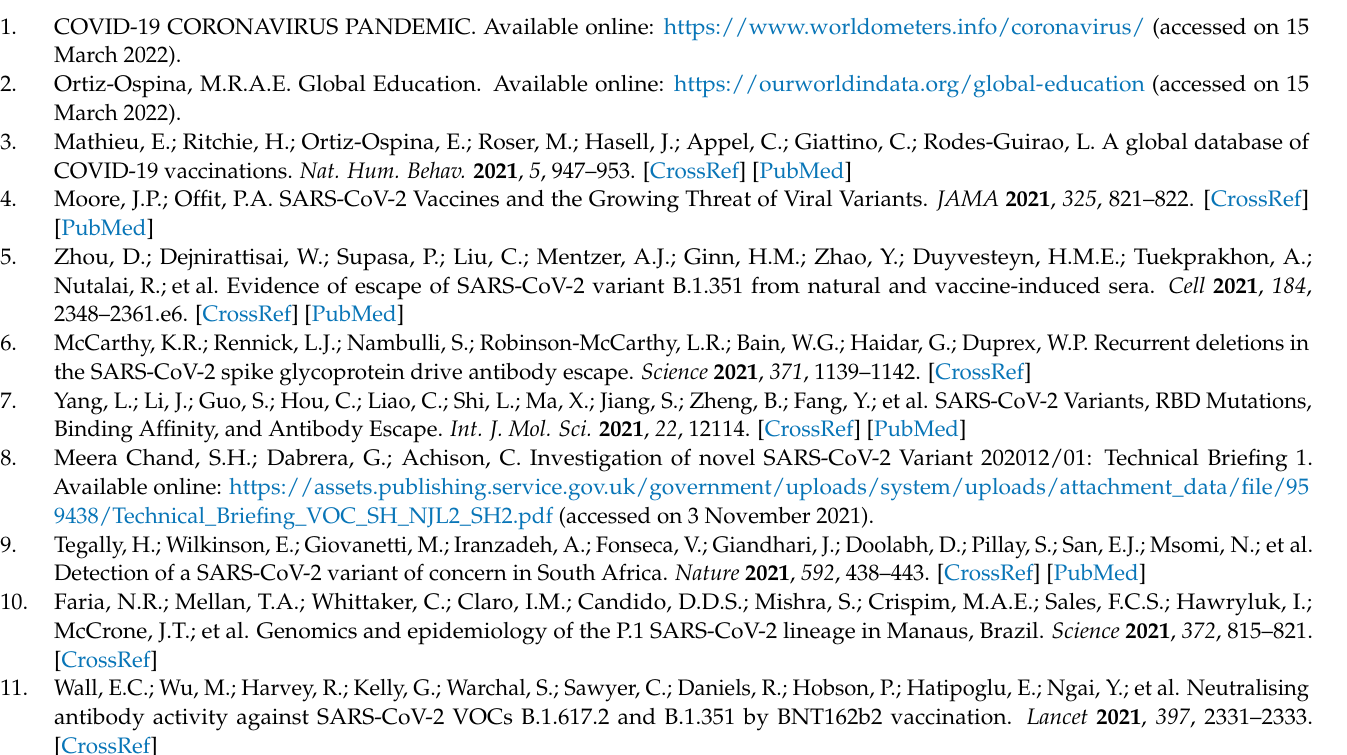
Table S3 available at https://doi.org/10.6084/m9.figshare.16929463. Conflicts of Interest: The authors declare no conflict of